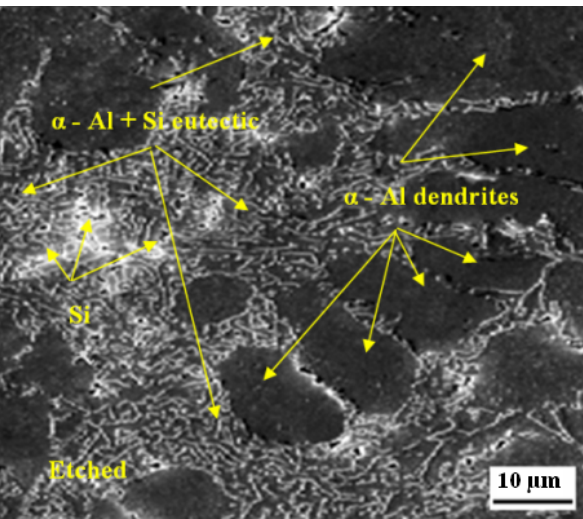
Figure 7: (SEM) Etched microstructure of the Al-12Si coating: α -Al dendrites, α -Al + Si